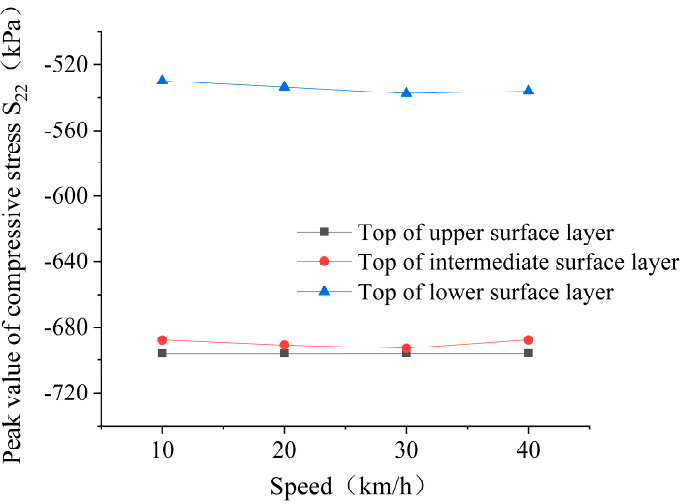
Figure 9. Variation in peak value of vertical compressive stress with vehicle speed.